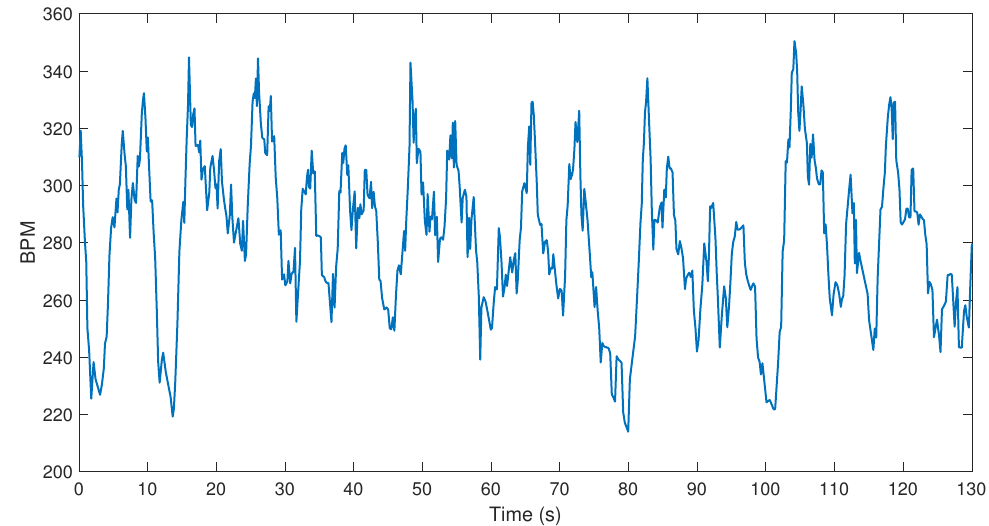
Figure 4. Initial heart rate estimation without adaptive